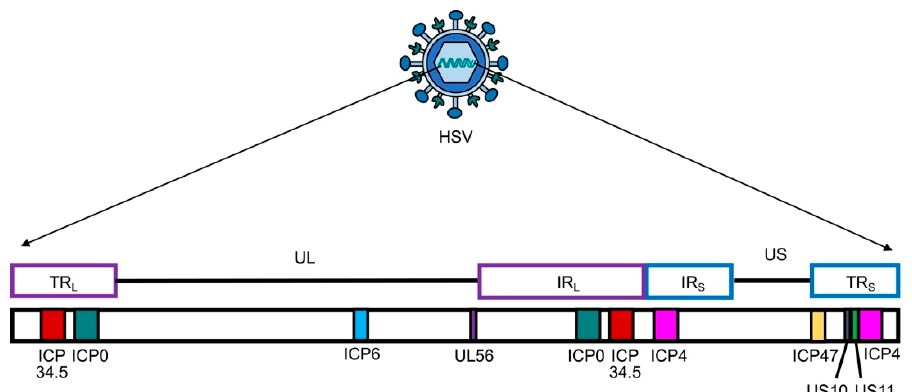
Figure 2. Schematic presentation of herpes simplex virus (HSV) genome with unique long (UL) and short (US) sequences. TR L or S —terminal repeat long or short; IR L or S —internal repeat long or short. Only genes that are modified and/or deleted during construction of OHSV-IL12 are presented. ICP, infected cell protein. Cells 2020 , 9 , x